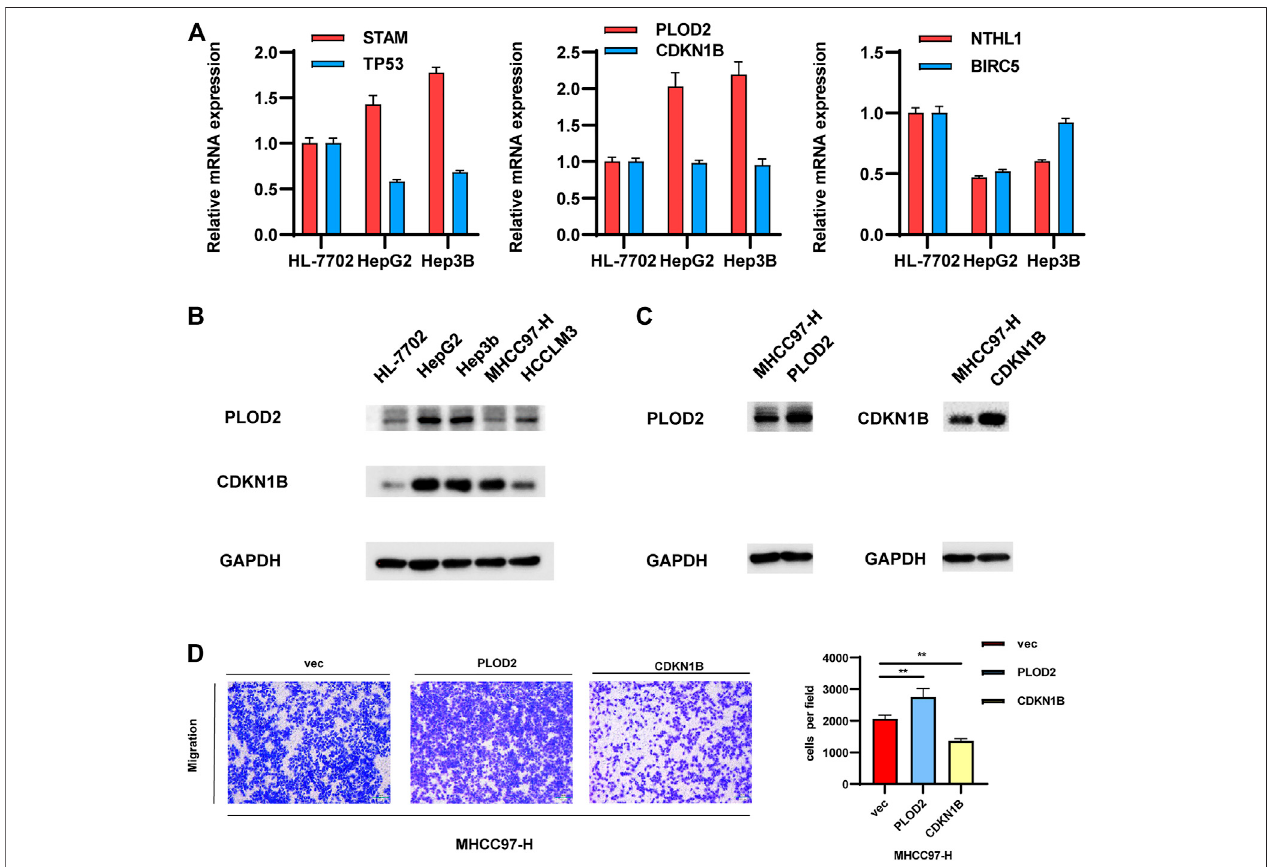
FIGURE 3 | Validation of the gene pairs that make up the model. (A,B) Examining the expression levels of representative gene pairs with the large coef fi cient in normal-liver cell line and in several common HCC cell lines. (C,D) . Validate the effects of representative gene pair in HCC cell lines.